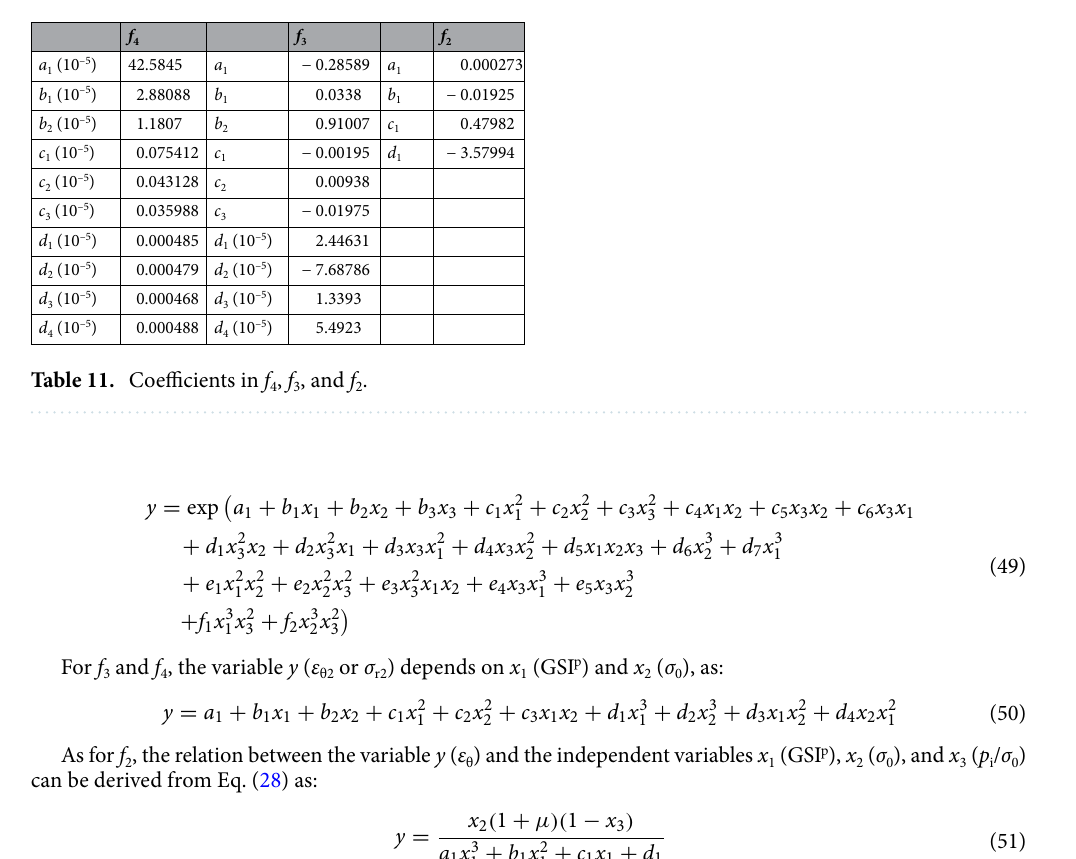
Table 10. σ 0 varies from 5 to 50 MPa with intervals of 5 MPa. p i / σ 0 ranges from 0 to 1 MPa and 10 to 20 values are selected for different combination of p i and σ r2 . f 2 , f 3 and f 4 are merely correlated to the peak geological parameters in the elastic zone. The regression model is composed of twelve equations: three equations are for f 2 , f 3 and f 4 ,